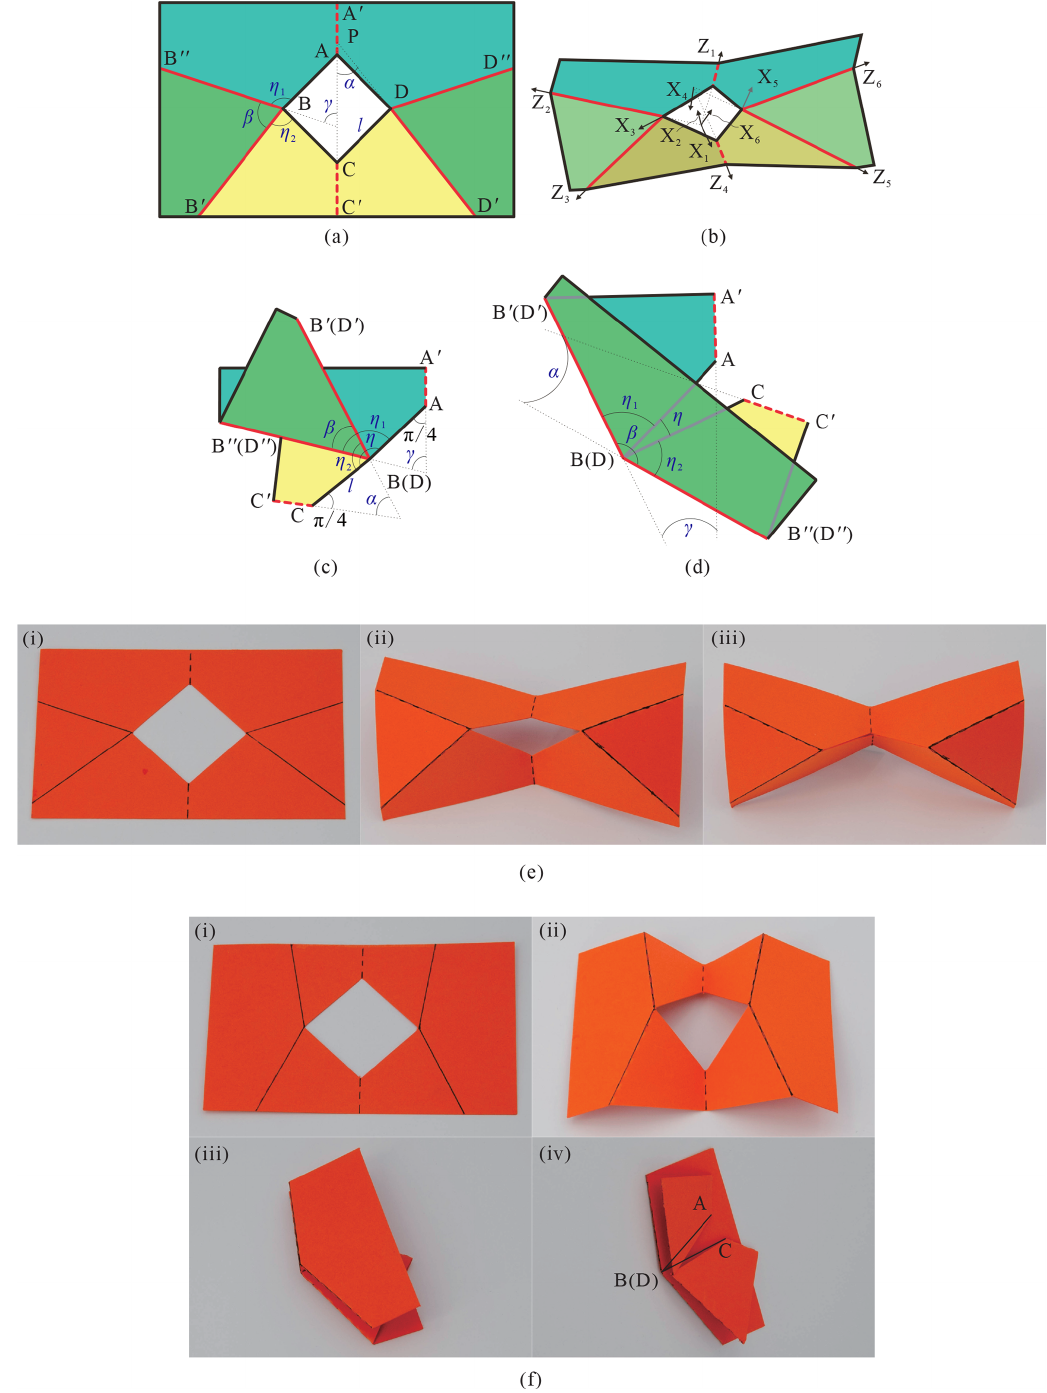
Figure 8. The six-crease pattern for scheme III (a) at the deployed configuration, (b) at the folding configuration, (c) at the fully folded configuration with interference and (d) with no interference, demonstrated with physical models (e) with interference, α = 5 π/ 18, β = π/ 3, γ = 7 π/ 18, and (f) with no interference, α = π /18, β = 29 π/ 36, γ = 5 π/